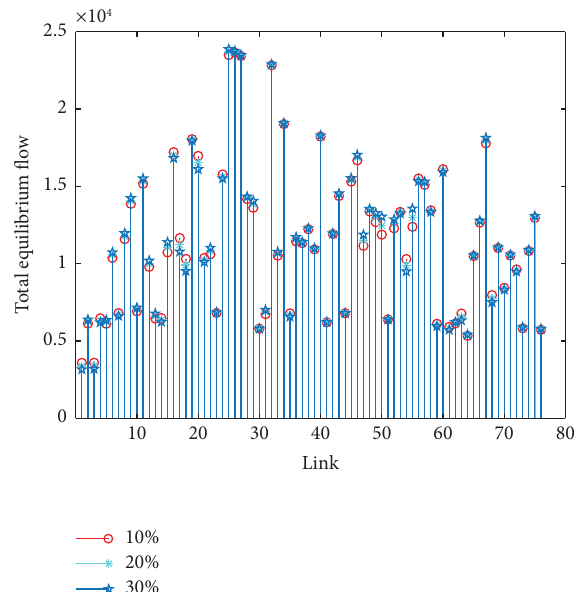
Figure 6: Te total equilibrium fow under diferent BEV market